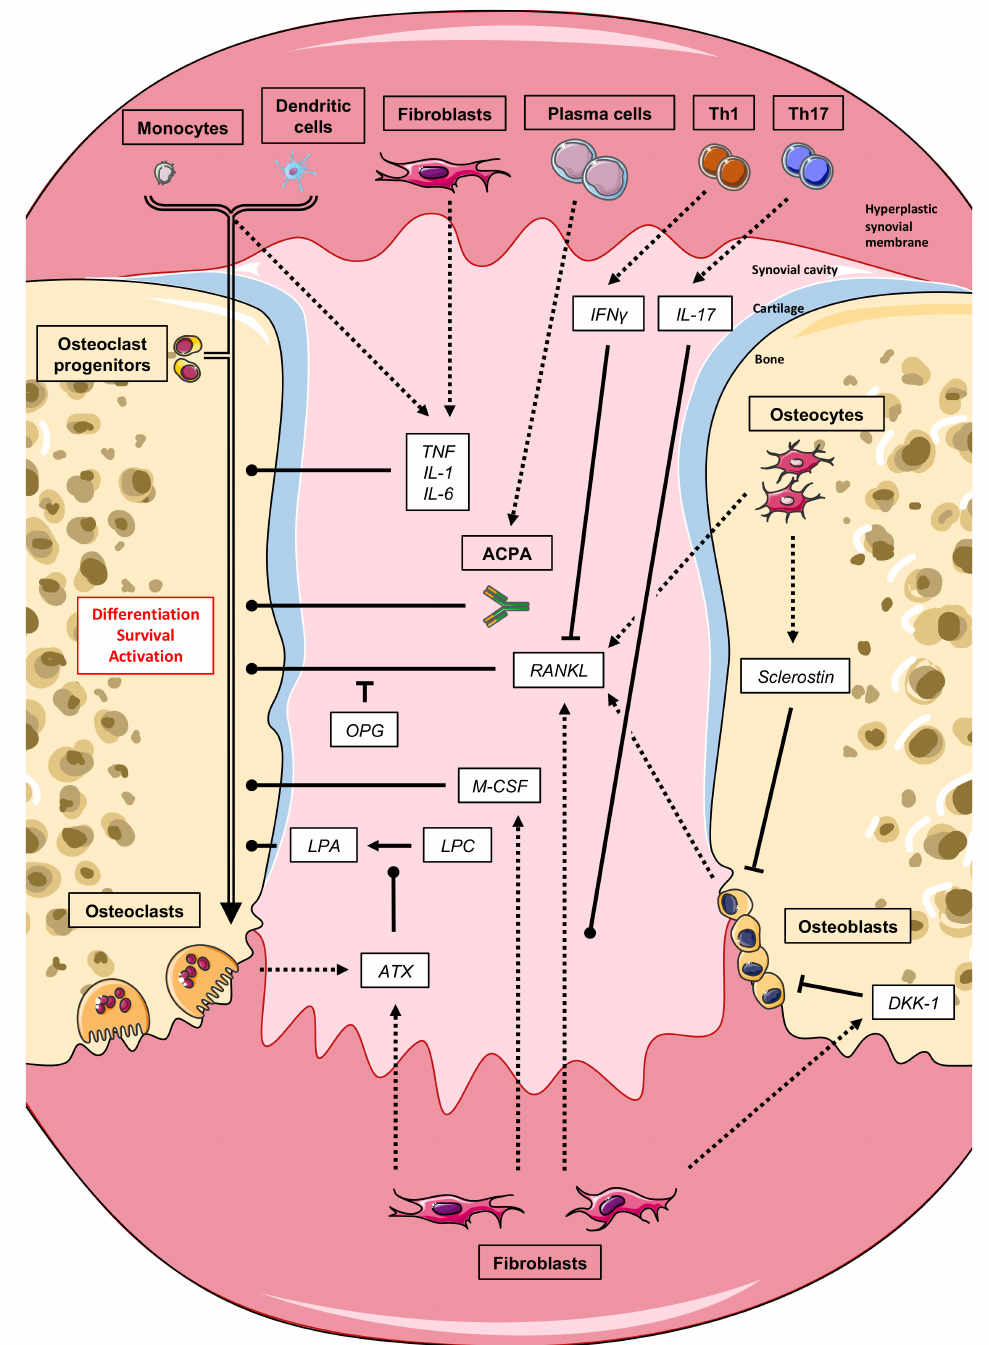
Figure 2. Synovial membrane and bone interactions in rheumatoid arthritis. The inflamed synovium produces inflammatory mediators that enhance osteoclastogenesis, mostly by the upregulation of the receptor activator of NF- κ B ligand (RANKL), leading to articular bone erosions development. In addition, osteoclasts as well as their precursors can be directly activated by anti-citrullinated protein antibodies (ACPAs) present long before during the pre-clinical phase of the disease. Osteoblast differentiation, on the other hand, is inhibited by antagonists of the Wnt signaling pathway, including Dickkopf (DKK-1) and sclerostin, preventing erosion repair. ACPA: Anti-citrullinated peptide antibodies; ATX: Autotaxin; DKK-1: Dickkopf related protein 1; IFN: Interferon; IL: Interleukine; LPA: Lysophosphatidic acid; LPC: Lysophosphatidylcholine; M-CSF: Macrophage colony-stimulating factor; OPG: Osteoprotegerin; RANK: Receptor activator of nuclear factor kappa B; RANKL: RANK ligand; TNF: Tumor necrosis factor; Th: T-cell; dashed triangle arrowheads: Secretion; simple triangle arrowheads: Chemical reaction; round arrowheads: Activation; flat arrowheads: